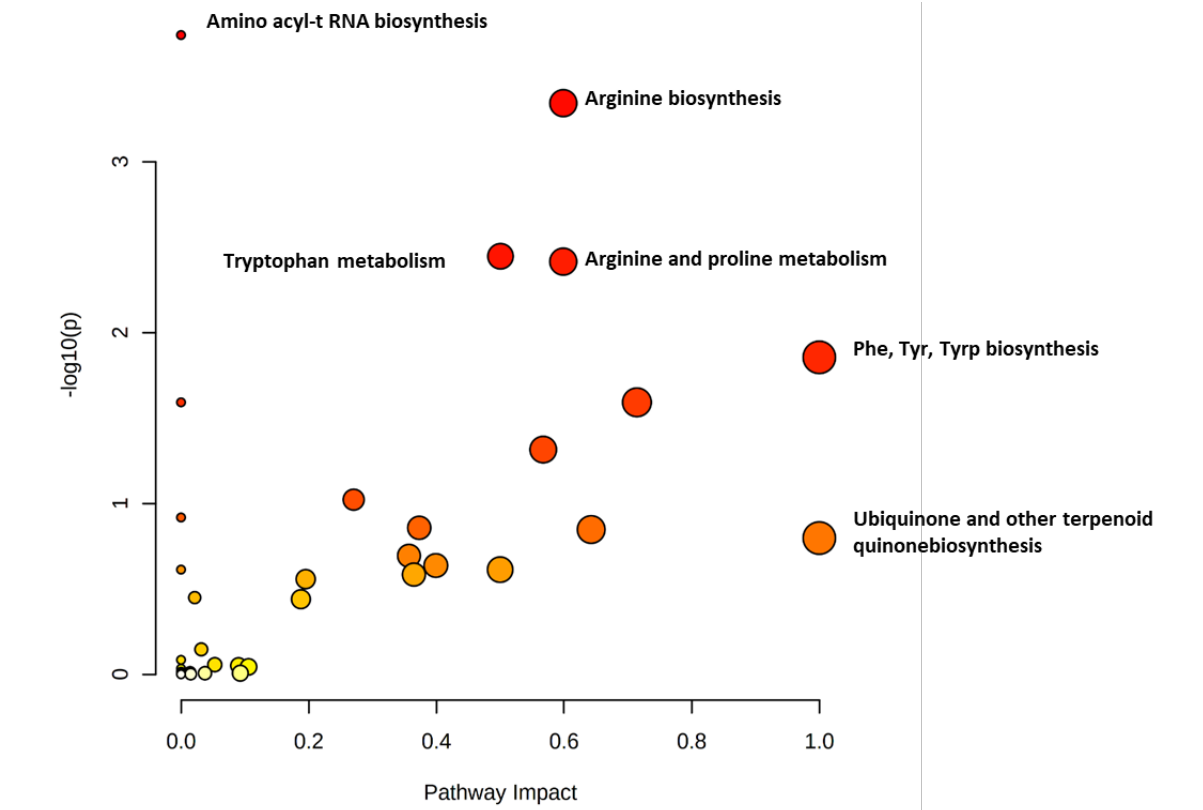
Figure 3. Pathway analysis shows the altered pathways in NS including amino acid metabolism and ubiquinone biosynthesis. The node color and size of the circle reflect the p-value and the pathway impact value, respectively.